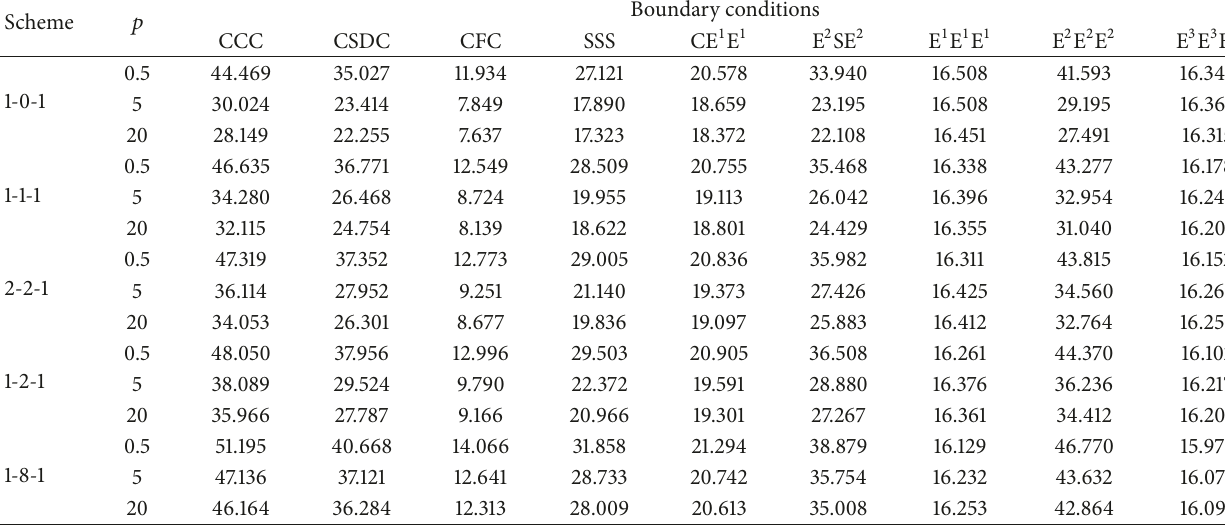
Table 9: Fundamental frequency parameter Ω for Type 1-1 circular sector plate with various boundary conditions ( ℎ/𝑅 1 = 0.2, 𝑝 2 = 𝑝 , and 𝜙 = 120 ∘ ).